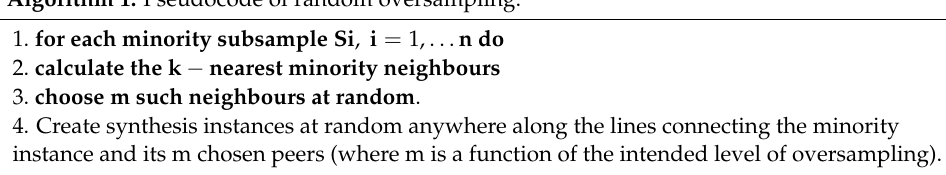
Algorithm 1. Pseudocode of random